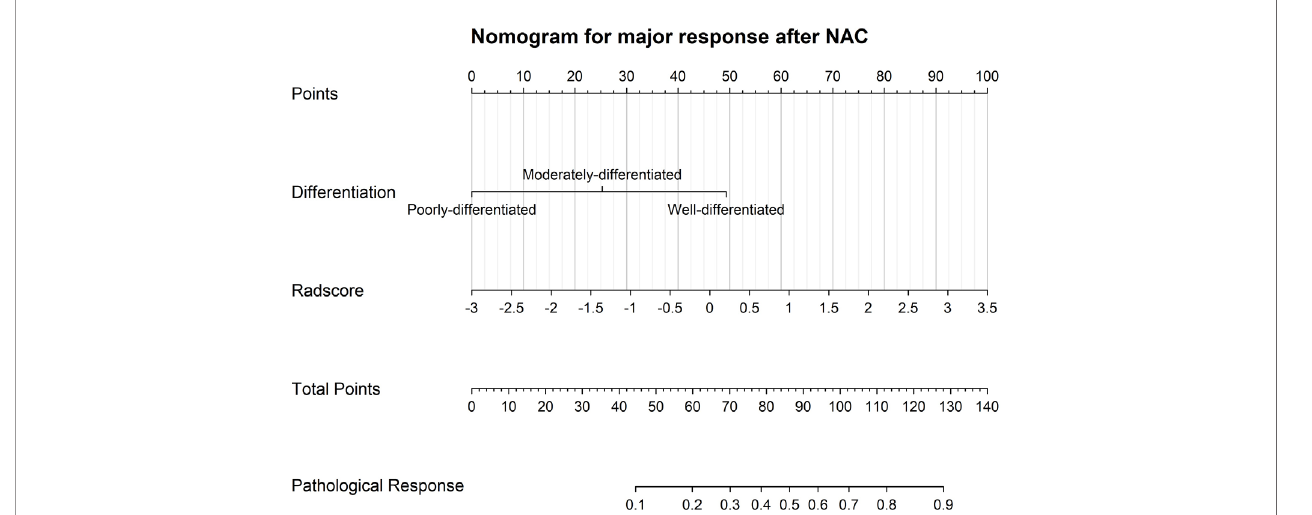
FIGURE 4 | A visualized model for predicting major pathological response after neoadjuvant chemotherapy incorporating only pre-intervention characteristics, such as adenocarcinoma differentiation and CT radscores.